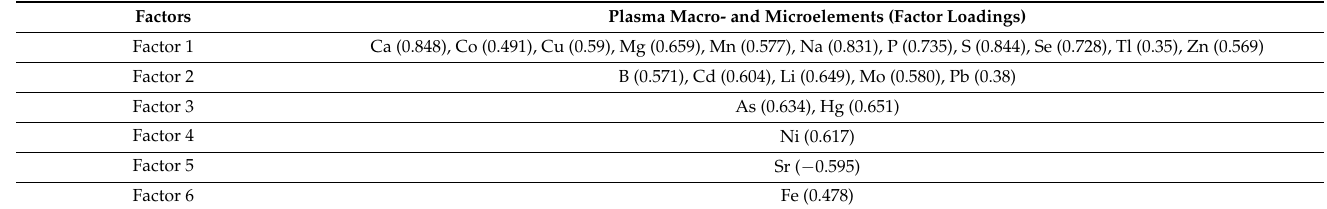
Table 3. Plasma macro- and microelements and their factor loadings for 6 groups (factors) (given by the PCA).